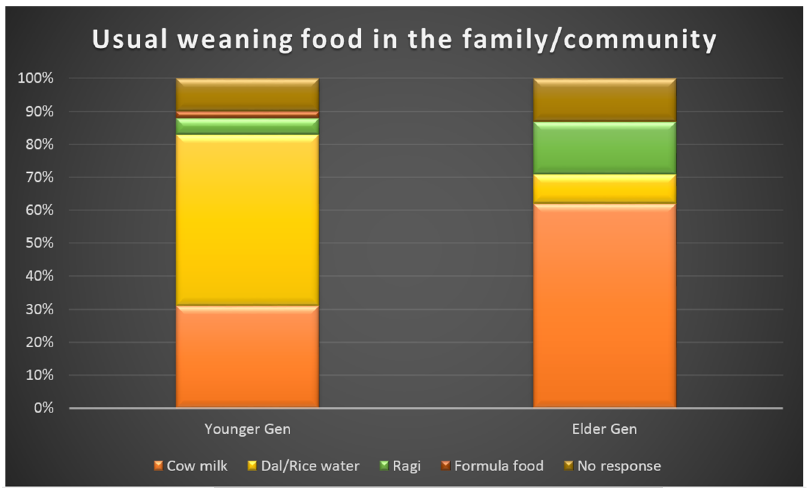
doi:10.1371/journal.pone.0126575.g001